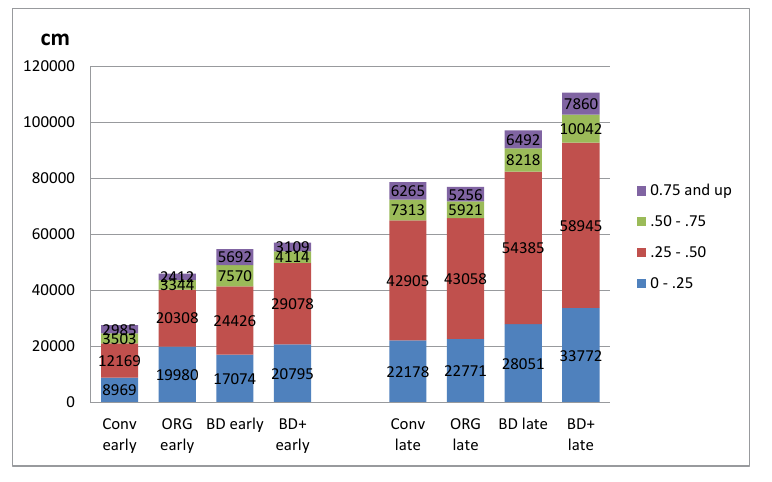
Figure 9: Root diameter distribution 1999 at early (July) and late (August) sampling dates Figure 9: Distribution of root length by root diameter size distribution (in mm) in 1999 at early (July) and late (August) sampling